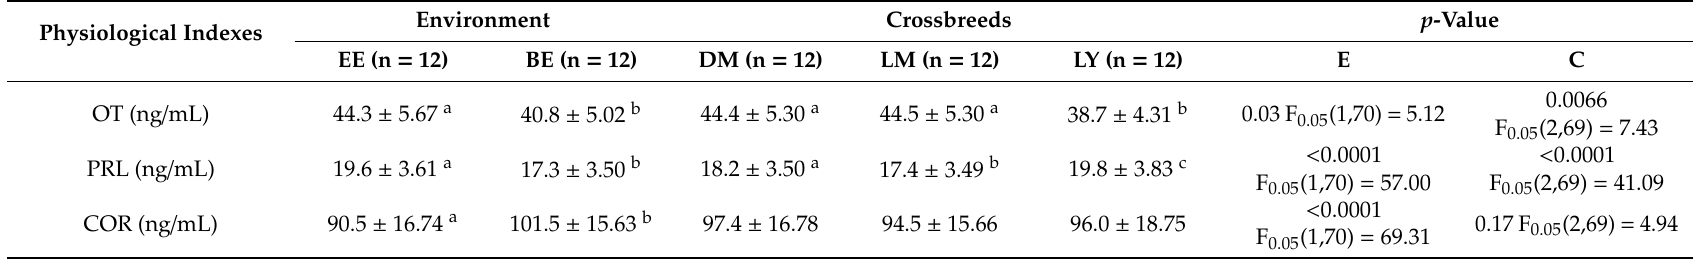
Table 6. Stress and immune levels of sows for di ff erent environments and crossbreeds.